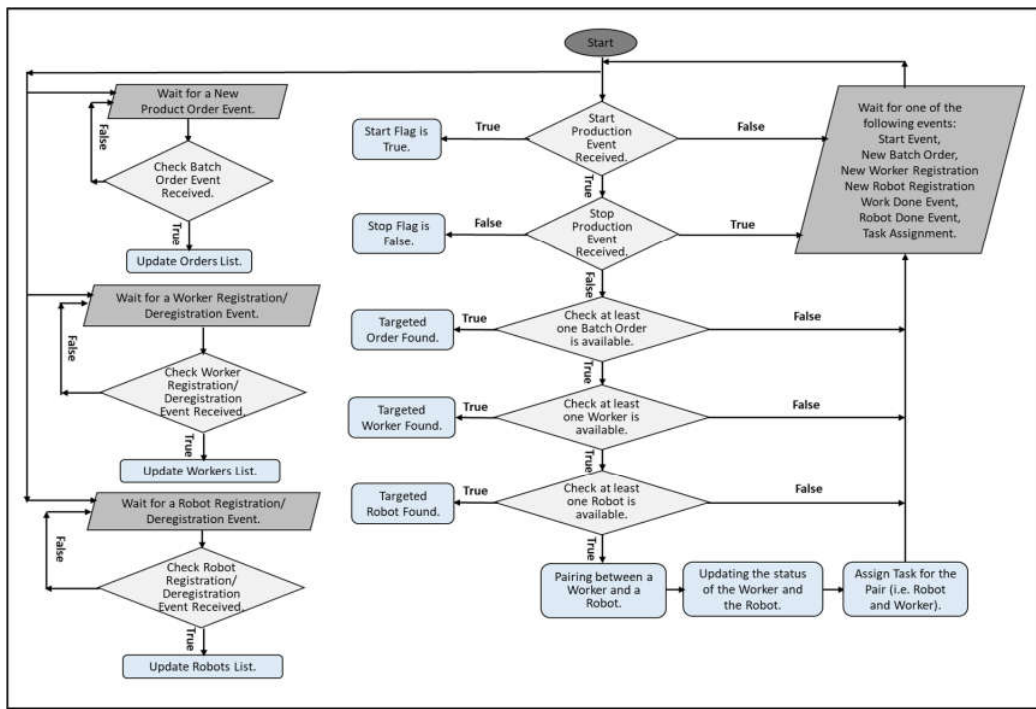
Figure 9 . SH Task Assignment Control Algorithm. Figure 9. SH Task Assignment Control